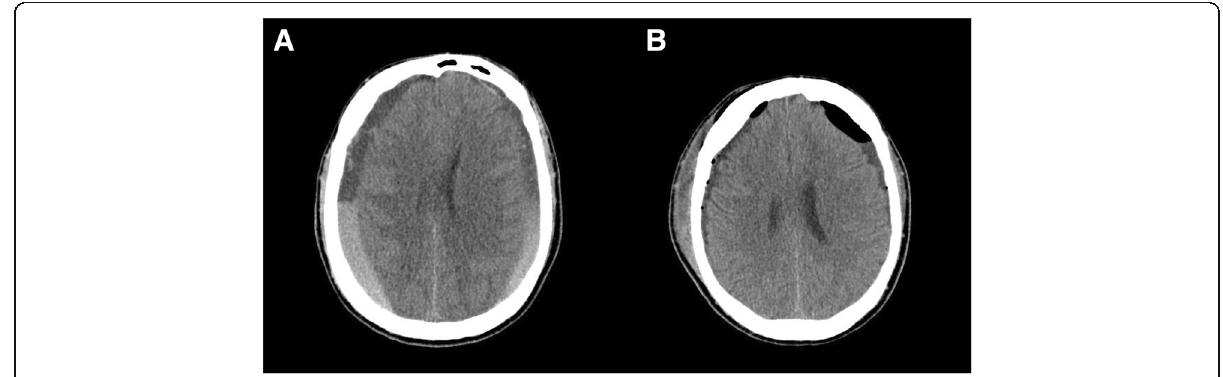
Fig. 1 Pre- and post-operative non-contrast head computerized tomography scan. Legend: Non-contrast, axial, head computerized tomography scan ( a ) significant for bilateral sub-acute subdural hematomas with mass effect on the midline structures and ( b ) following bilateral burr hole evacuation of the